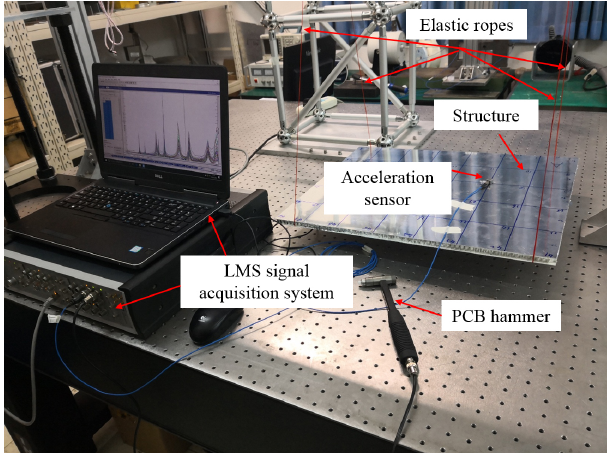
Figure 10. Field layout of the honeycomb plate modal